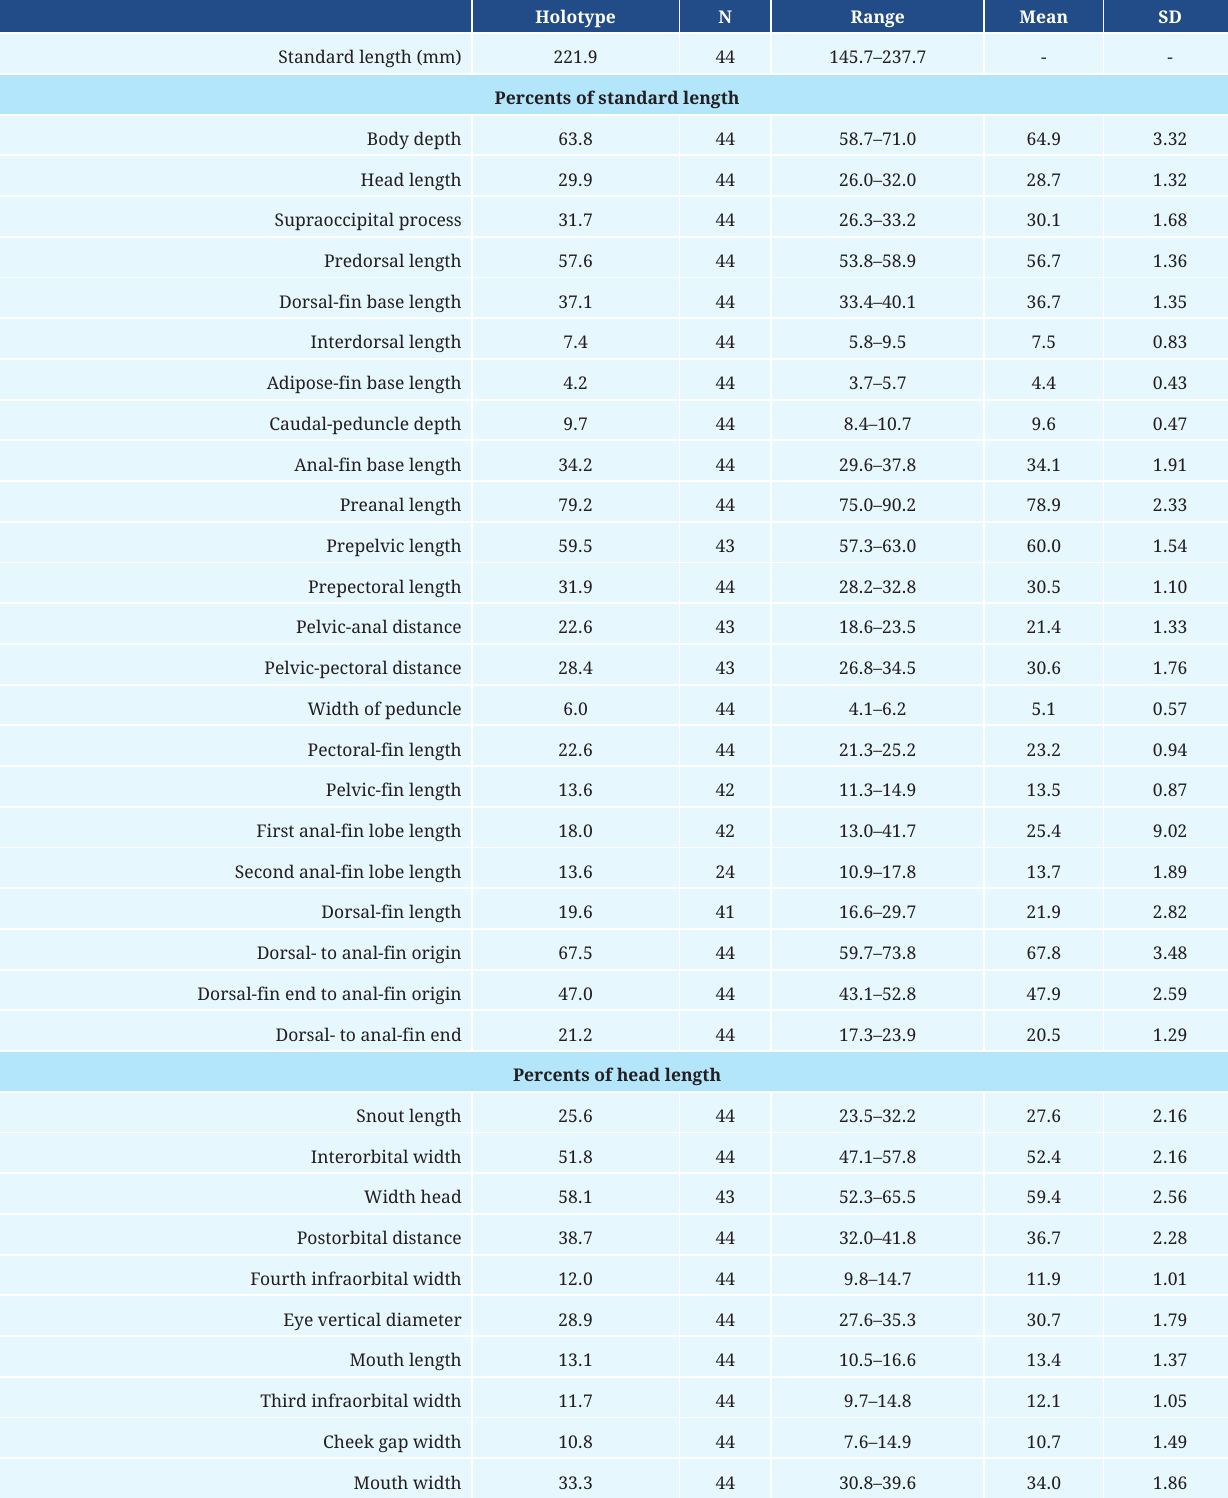
TABLE 1 | Morphometric data of Myloplus nigrolineatus , new species. Range including the holotype; N = number of specimens, SD = standard